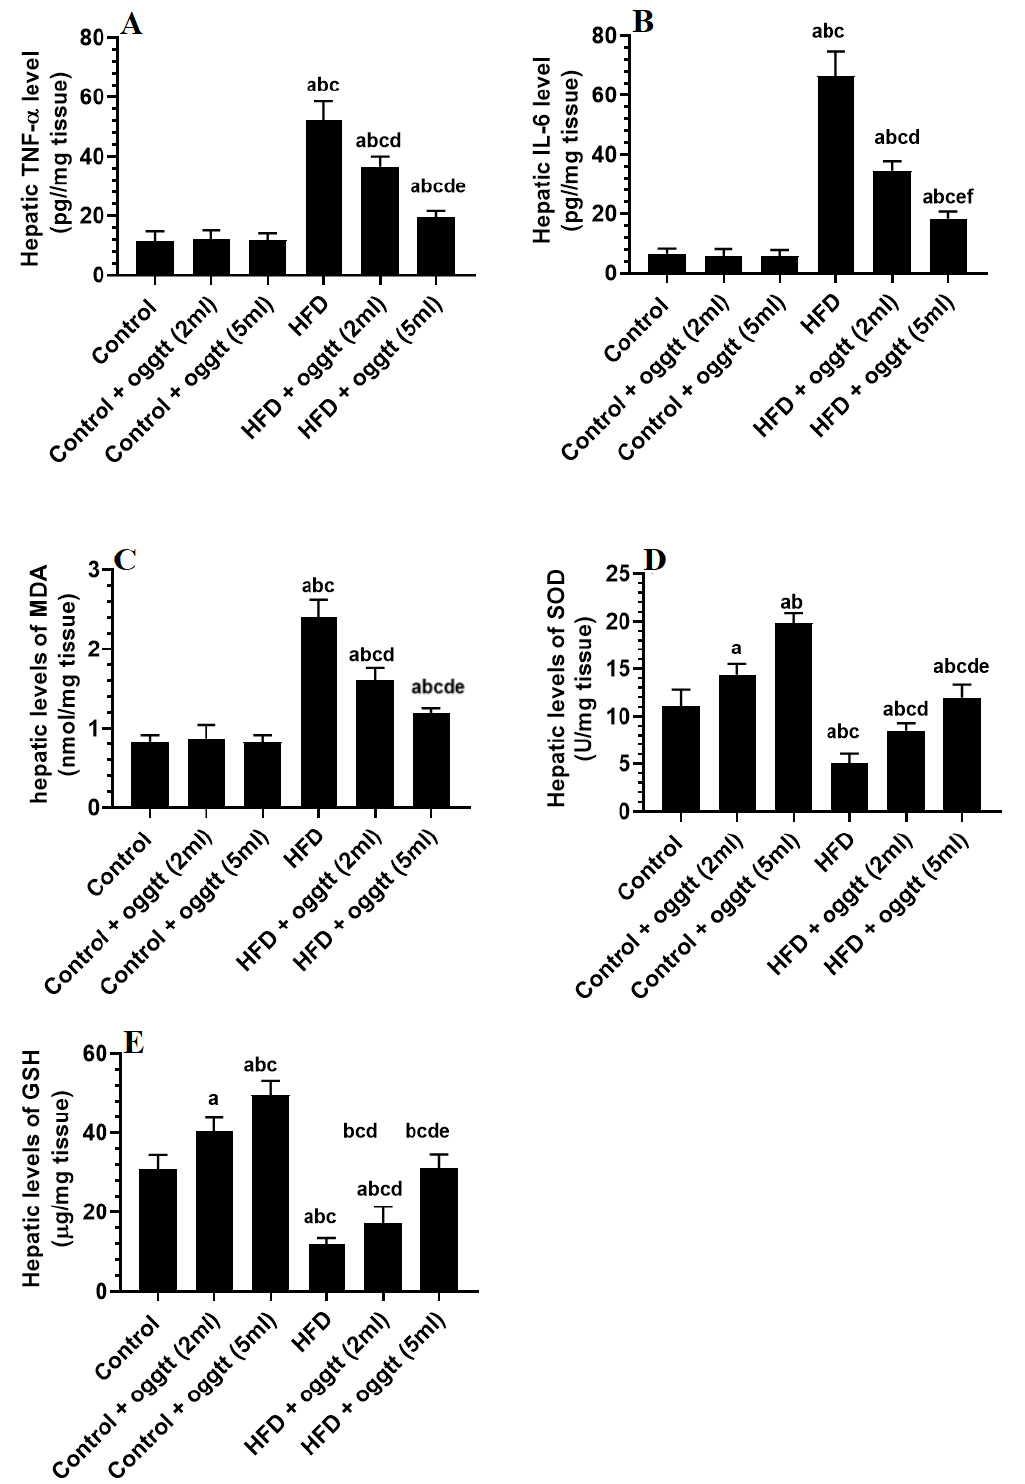
Figure 4. Oggtt suppresses the increase in the levels of tumour necrosis factor- α (TNF- α ) ( A ), interleukin-6 (IL-6) ( B ), and malondialdehyde ( C ) in the livers of high-fed diet (HFD)-fed rats but stimulates the hepatic levels of superoxide dismutase (SOD) ( D ) and glutathione (GSH) ( E ) in both the control and HFD in a dose-dependent manner. The data are expressed as means ± SD for n = 8 rats/group. a, vs. control; b, vs. control + oggtt (2 mL); c, vs. control + oggtt (5 mL); d, vs. HFD; and e, vs. HFD + oggt (2 mL); f, vs. HFD + oggt (5 mL).